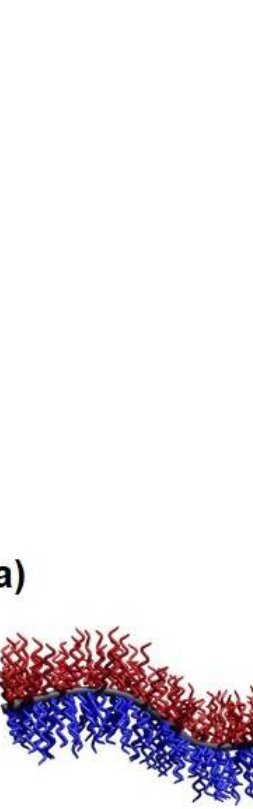
Figure 1. Schematic depiction of a cylindrical ( a ) Janus micelle, ( b ) block co-micelle, and ( c ) patchy micelle. For the preparation of patchy micelles and polymersomes from amorphous BCPs, three main strategies can be applied: (i) self-assembly of ABC triblock terpolymers in selective solvents for the incompatible A and C blocks [42–48]; (ii) co-assembly of AB and CD diblock copolymers with selective interactions between the B and C blocks (e.g. hydrogen